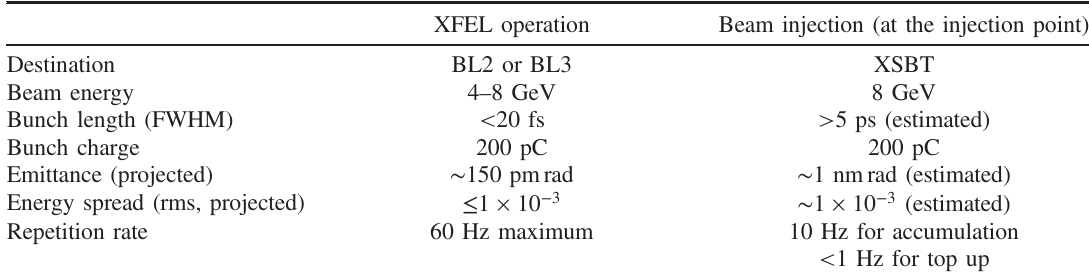
TABLE I. Electron beam parameters for the XFEL operation and the beam